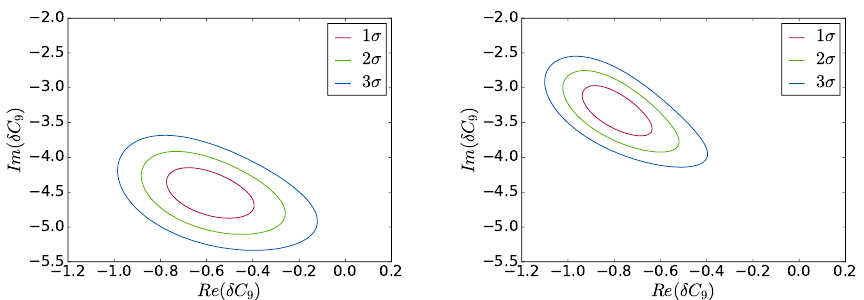
Figure 7 . Projections of the real and imaginary part of (cid:14)C 9 assuming integrated luminosity of 300 fb (cid:0) 1 . Both (cid:14)C 9 and (cid:14)C 10 are allowed to vary. The contours on the left correspond to (cid:12)ts up to q 2 = 6 GeV 2 , and the contours on the right correspond to (cid:12)ts up to q 2 = 8 GeV 2